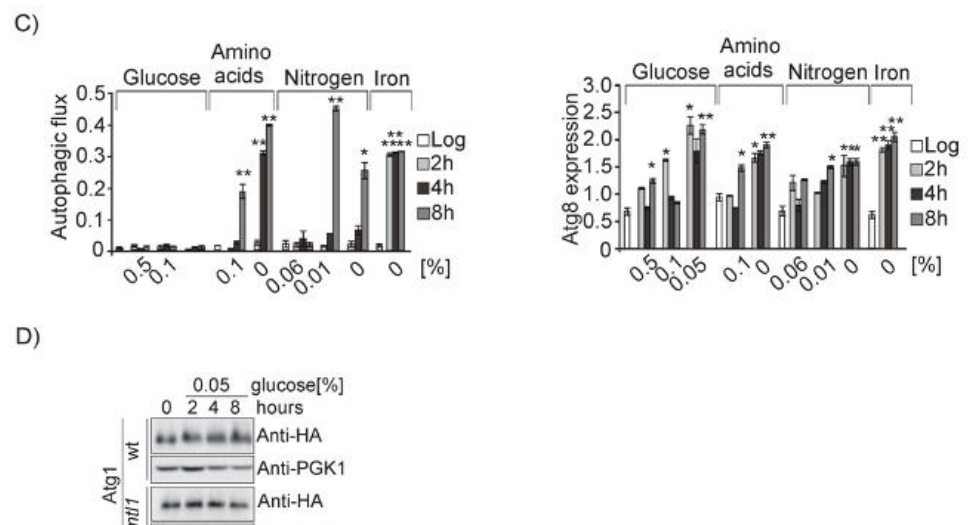
Figure 4. Mtl1 signals glucose limitation to autophagy machinery. ( A ) wt cells expressing GFP–Atg8 were exponentially grown in SD media. Aliquots were taken, washed, and transferred to different minimum media containing: 0.5, 0.1, or 0.05% glucose; 0.1 or 0% amino acids; 0.06, 0.01, or 0% nitrogen or medium without iron (0%). Autophagic flux and Atg8 expression were determined as in Figure 1B. The same experiments as in A were carried out in ( B ) gcn2 mutant cultures expressing GFP–Atg8 and in a ( C ) mtl1 strain expressing GFP–Atg8. ( D ) Atg1HA protein was identified by Western blot using anti-HA antibody, as in Figure 1A. Error bars in the histograms represent the standard deviation (SD) calculated from three independent experiments. Significance of the data was determinate by p -values from a Student’s unpaired t -test denoted as follows: * = 0.05 > p > 0.01; ** = 0.01 > p > 0.001; *** = 0.001 > p > 0.0001; **** = p >